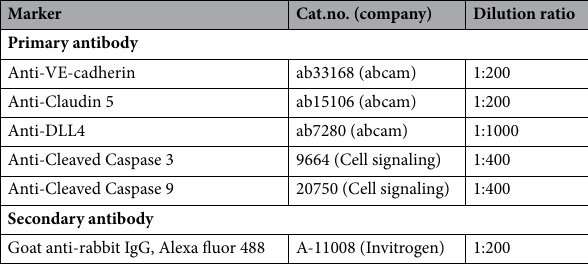
Table 1. Primary and secondary antibodies.